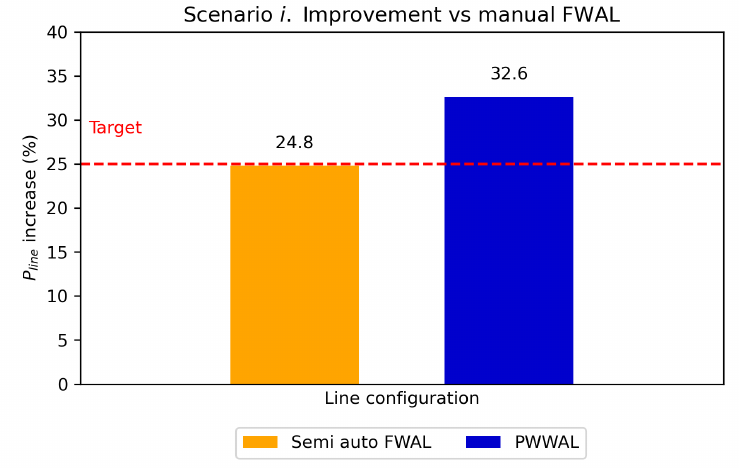
Figure 3. Line productivity increase of semiautomated FW and parallel walking-worker with respect to manual FW line configuration under standard demand conditions ( scenario i